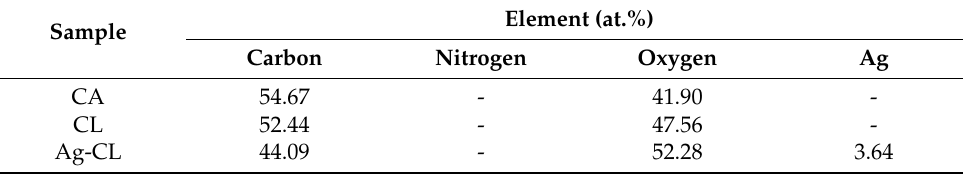
Table 2. Elemental composition of CA, CL, and Ag-CL nanofibers using EDS analysis.